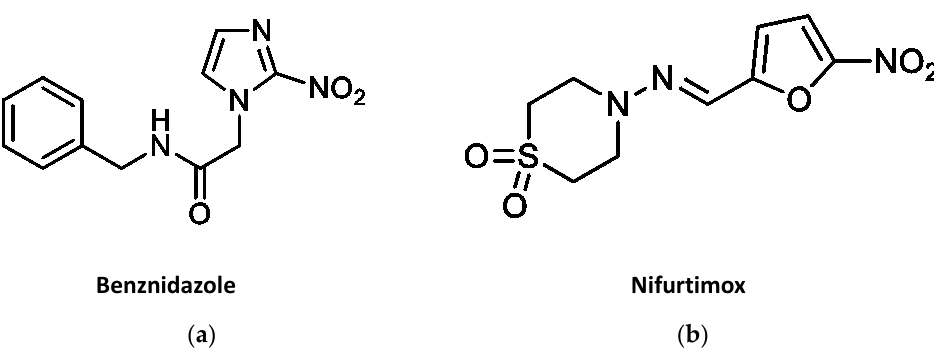
Figure 1. Drugs in clinical use against American trypanosomiasis (Chagas disease). ( a ) Benznidazole. ( b ) Nifurtimox.